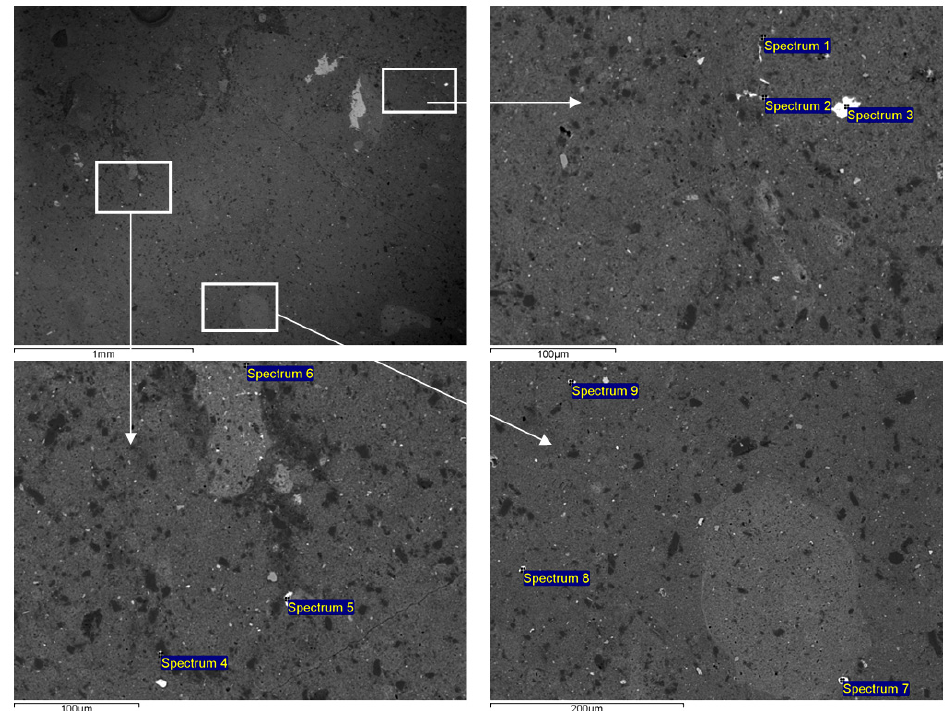
Figure 11. Bauxite deposit Borova brda. Analysed field 3—sample 180, with details and analysed points . Spectrum 1–6 — REE–carbonate; Spectrum 7–8 — Monazite; Spectrum 9 — Xenotime.